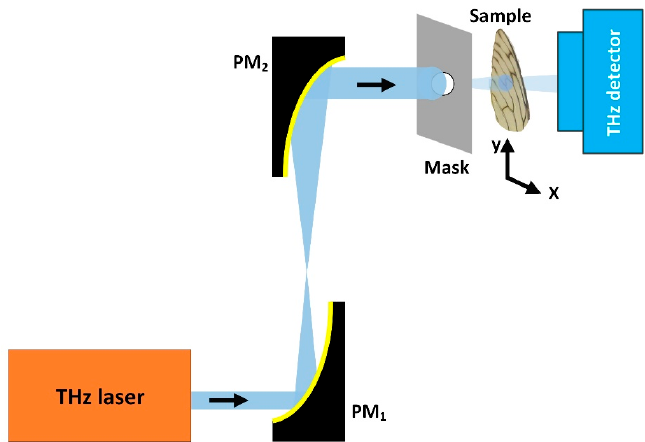
Figure 11. Schematic layout of the setup of CW THz ptychography.